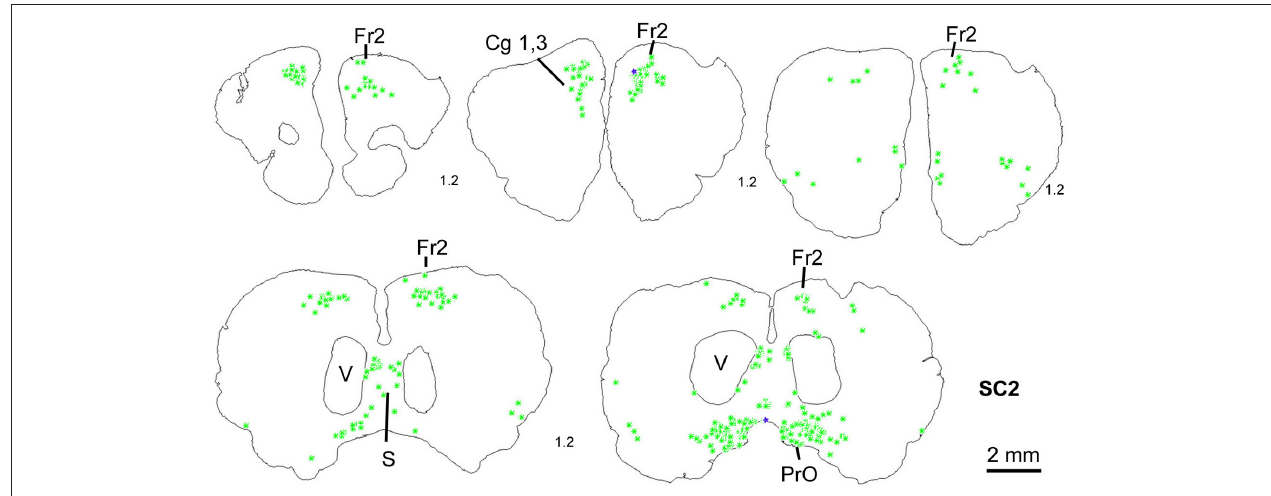
the superficial and intermediate layers of the SC. Predominantly the superficial layers of SC were injected in 2 cases (SC3, SC4) and the superficial and intermediate layers in case SC8 ( Table 1 ). Even though the muscles injected in these cases dif- fered the resulting labeling was comparable. Therefore, we here only present the data of case SC4. The injection site is depicted in Figure 7A in a reconstruction of the dorsal view of the SC (left), in a section through the center of the injection (middle), as well as in a photomicrograph (right). Red outlines indicate the FITC injection site. The resulting labeling is demonstrated in the frontal sections shown in Figure 8 . The majority of cells